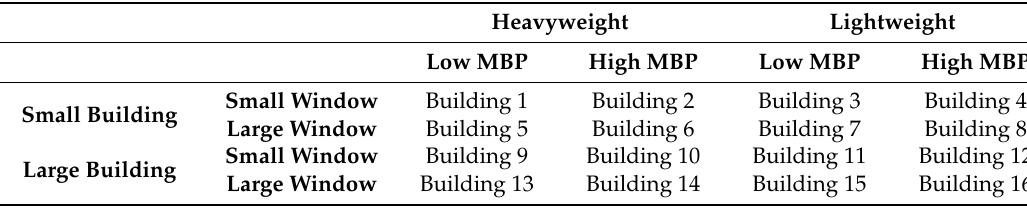
Table 2. Generic sacred building matrix.